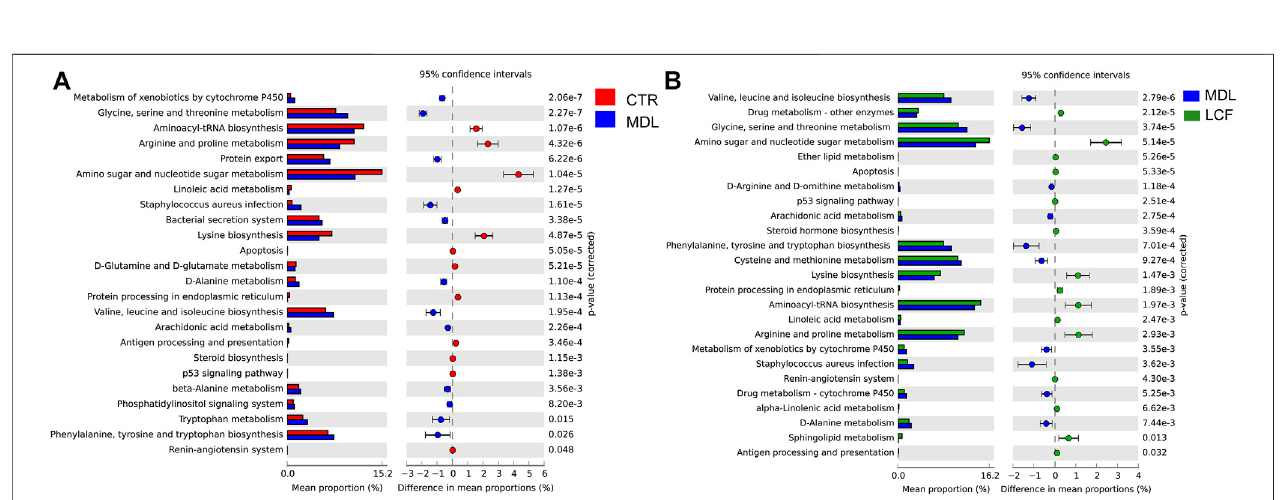
FIGURE 12 | Comparisons of functional pathways in microbes from the CTR and MDL groups (A) and in the LCF and MDL groups (B) . n = 8 rats per group.